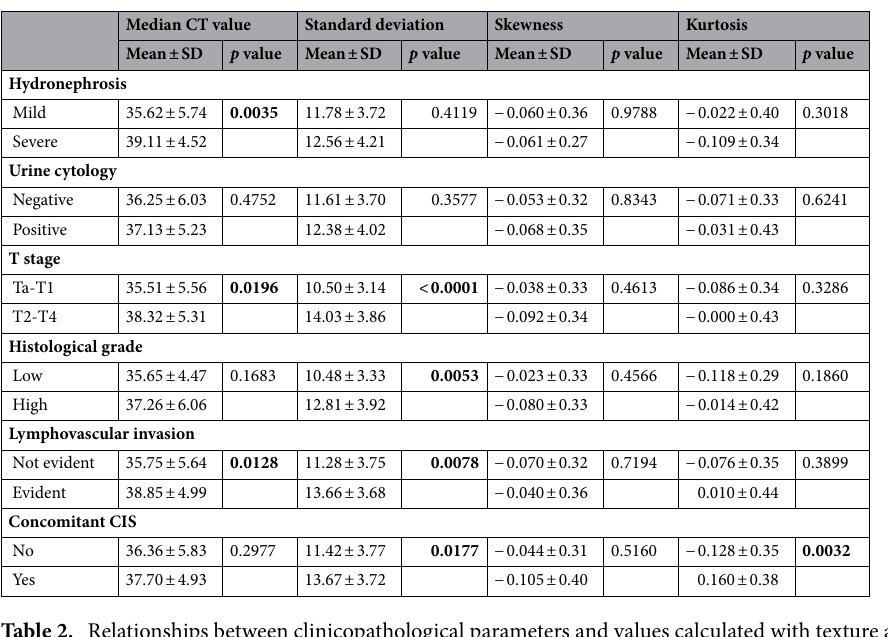
Table 2. Relationships between clinicopathological parameters and values calculated with texture analysis. CT computed tomography, SD standard deviation, CIS carcinoma in situ. The significance of bold means p < 0.05.